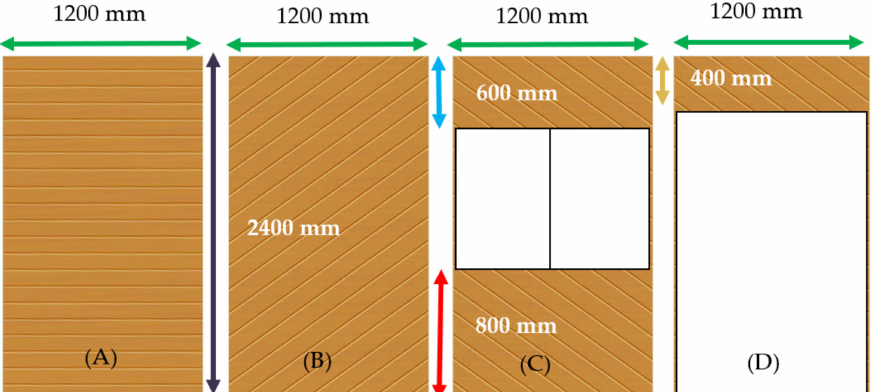
Figure 4. ( A ) whole shear wall in board pattern; ( B – D ) shear wall in plain board diagonal, windowed and with doors,